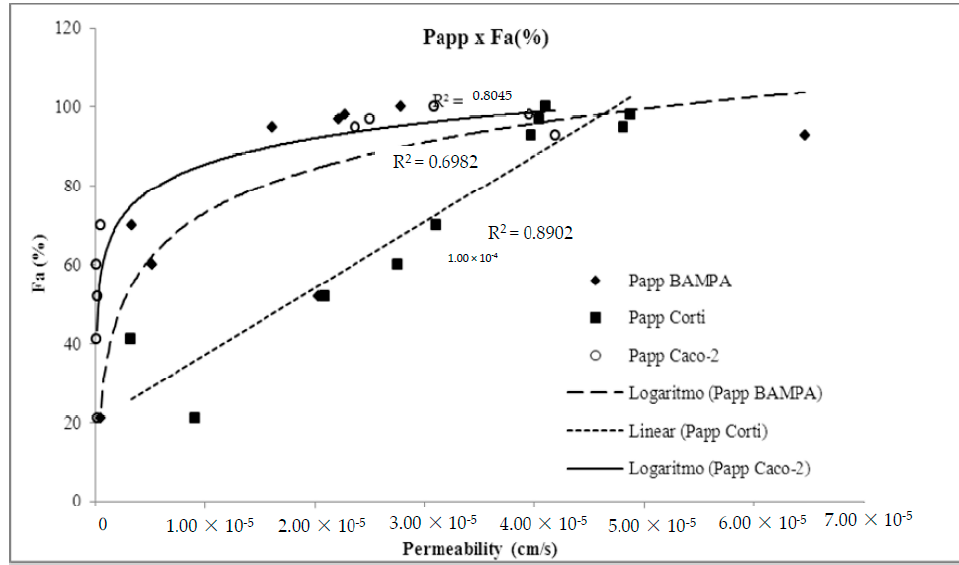
Figure 6. Demonstration of method suitability from Franz–PAMPA assay permeability and fraction of dose absorbed in humans (Fa%) compared to Caco-2 cells ( ο ) and Corti membrane ( ■ ). Actively transported drugs were removed for R 2 calculation. Corti membrane Papp ( ) correlation to %Fa (R 2 = 0.890) was essentially unchanged.